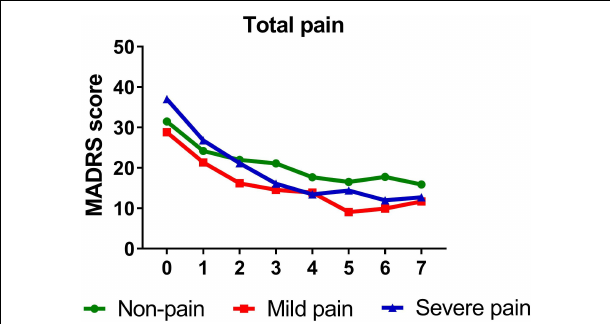
FIGURE 1 | Overall change in MADRS score across six infusions. Pain severity was defined by total score of SF-MPQ. Patients exhibiting no pain symptom were characterized as “non-pain,” patients exhibiting the mean or below the mean total pain score were characterized as “mild pain” and patients exhibiting above the mean total pain score were characterized as “severe pain.” MADRS, Montgomery-Åsberg Depression Rating Scale; SF-MPQ, short-form McGill Pain Questionnaire. Numbers on X -axis: 0 represents baseline, 1 ∼ 6 represent the next morning after each infusion, 7 represents 2 weeks after infusions (Day